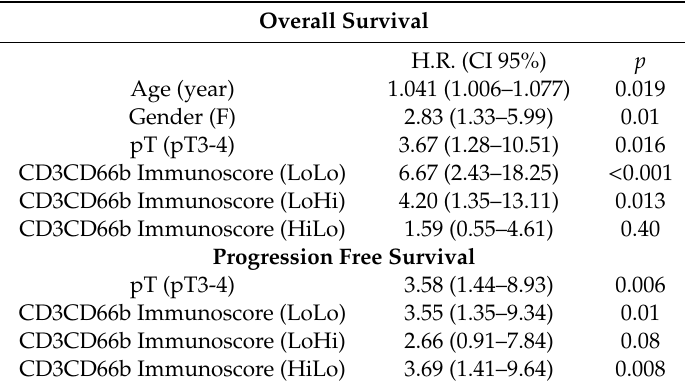
Table 4. Multivariable survival